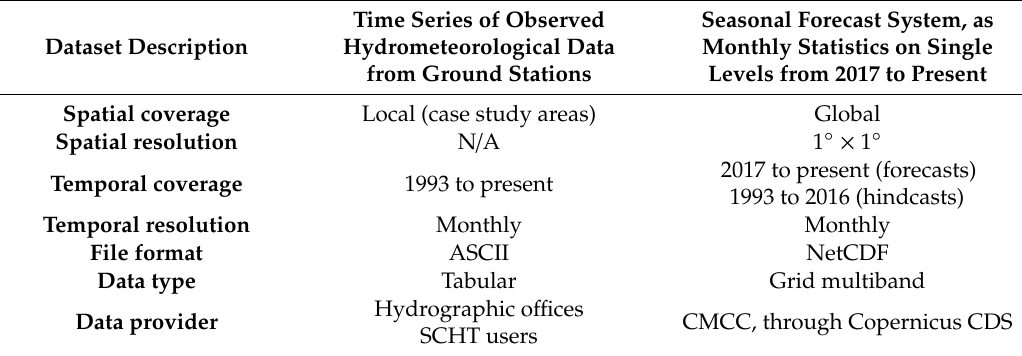
Table 1. Summary of data used in the Smart Climate Hydropower Tool